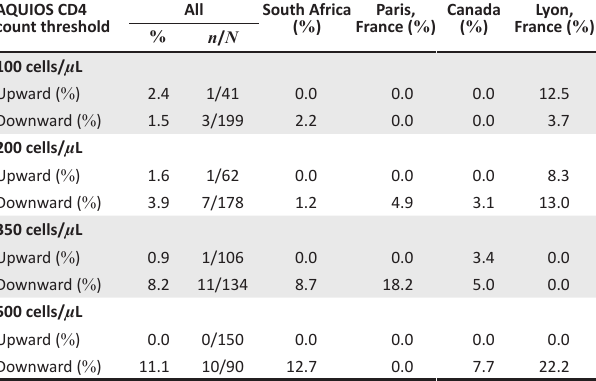
TABLE 2: Misclassification percentages at various CD4 count thresholds, Canada; Paris, France; Lyon, France; and South Africa, November 2014 to March 2015. AQUIOS CD4 count threshold